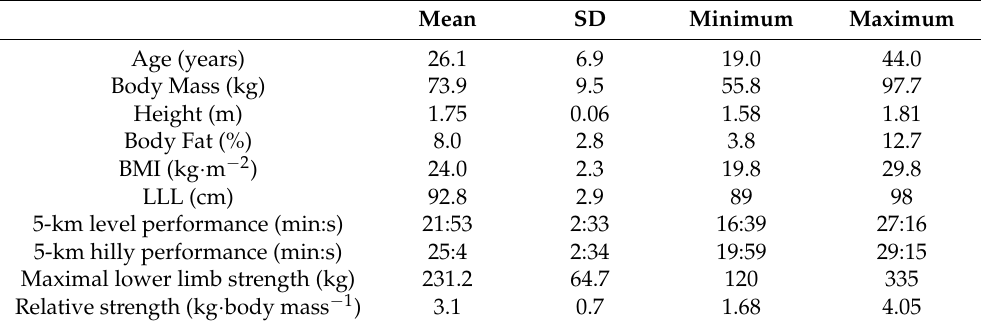
Table 1. Demographic, anthropometric, muscular strength and performance characteristics of